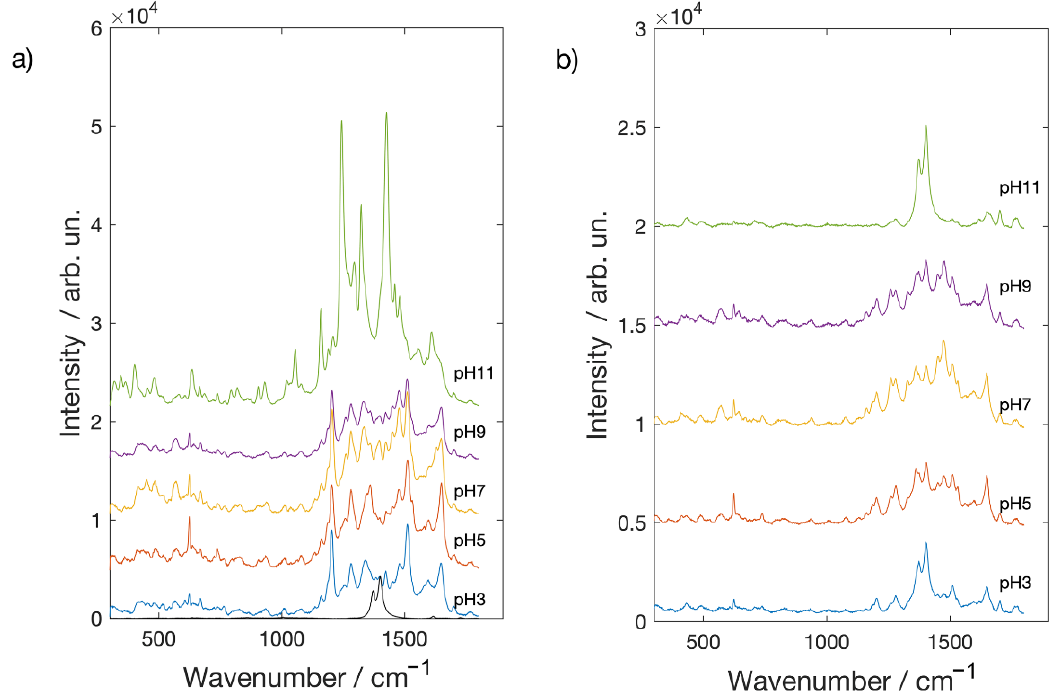
Figure 6. SERS spectra of Alizarin red-S acquired on polishing sheets coated with ( a ) Ag NPs and ( b ) Au NPs.